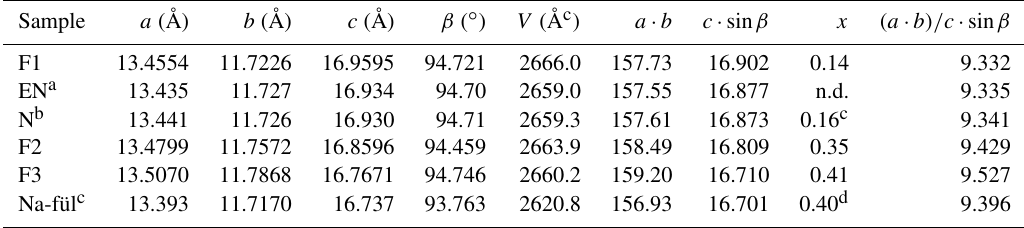
Table 7. Relationships between unit-cell geometry and Pb / Sb crossed-substitution coefficient x in fülöppite. Samples classified according to increasing (a · b)/(c · sinβ) ratio.